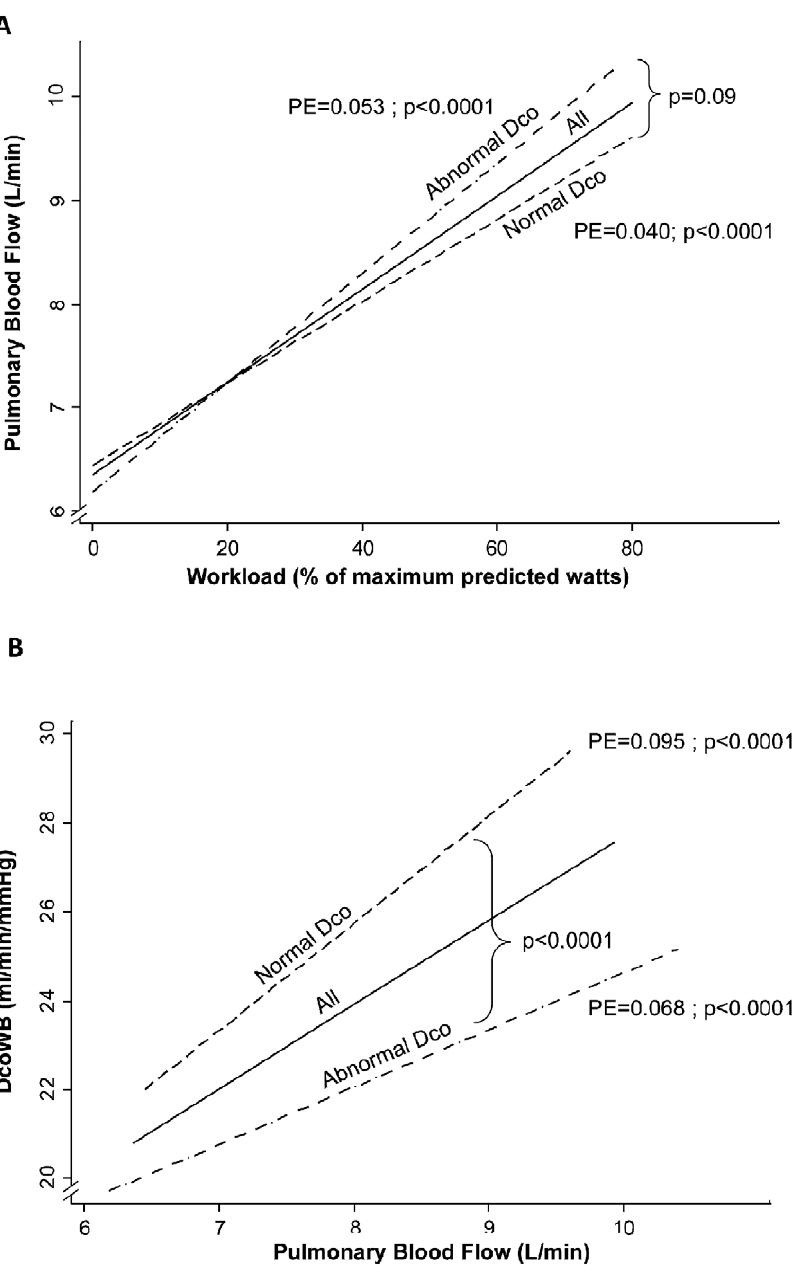
Figure 3. Association between within breath diffusing capacity (DcoWB), pulmonary blood flow, and workload. Generalized estimating equations were used to create linear regressions representing each association. A: Pulmonary blood flow increase with workload is not significantly different between the flight attendants with abnormal or normal diffusing capacity at rest. B: Diffusing capacity increases less with increasing blood flow in flight attendants with abnormal diffusing capacity at rest. PE: Parameter estimate from regression